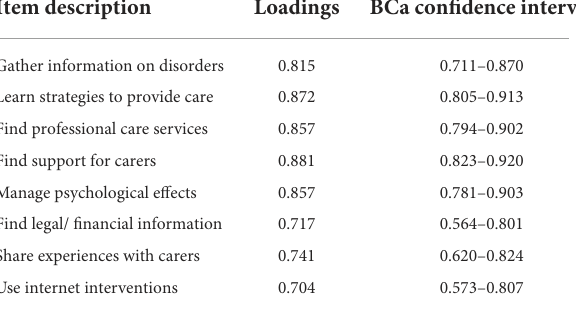
TABLE 4 Bias-corrected and accelerated (BCa) bootstrap 95% confidence intervals for loading